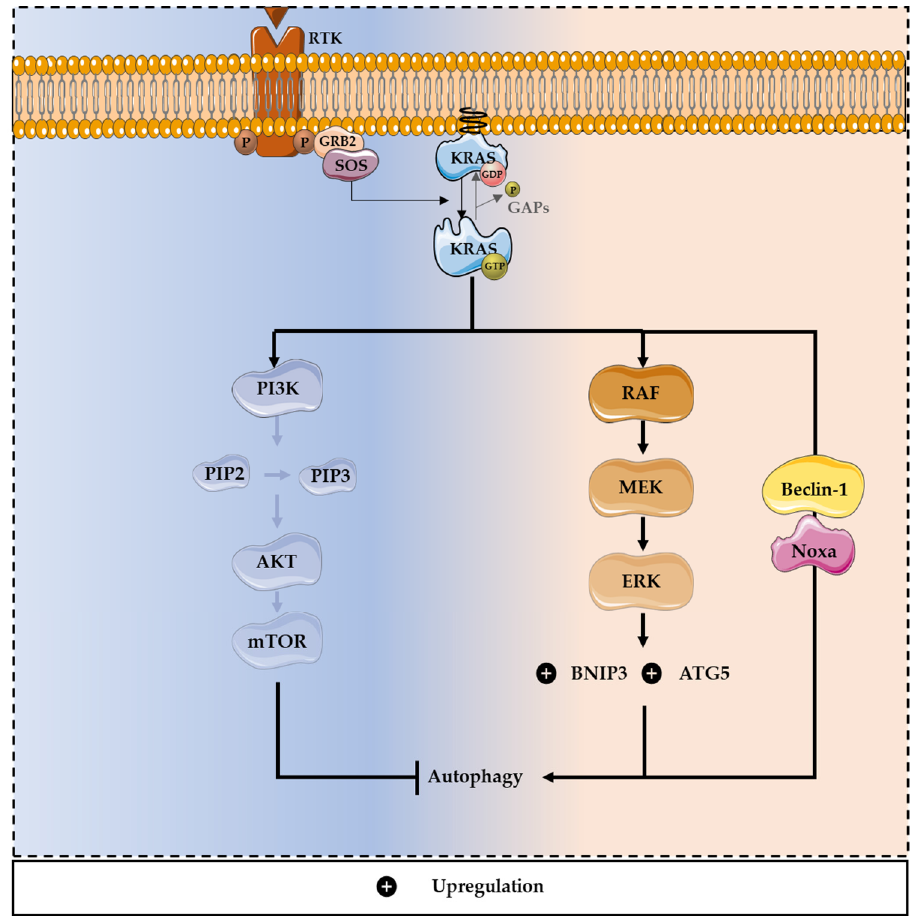
Figure 3. Dual role of mutated KRAS in autophagy modulation. KRAS-induced autophagy is mediated through upregulation of the MAPK pathway and downregulation of the PI3K/AKT pathway, promoting survival and tumor progression. Through the MAPK pathway, oncogenic KRAS can promote autophagy, enhancing the expression of essential constituents of the autophagy machinery, including ATG5. The activation of the MAPK pathway also leads to the up-regulation of a member of the Bcl-2 family, BNIP3, inducing autophagy and promoting CRC cell death. Moreover, oncogenic KRAS can induce autophagic cell death, through the upregulation of Beclin-1 and Noxa, a BH3-only protein and a member of the Bcl-2 family.